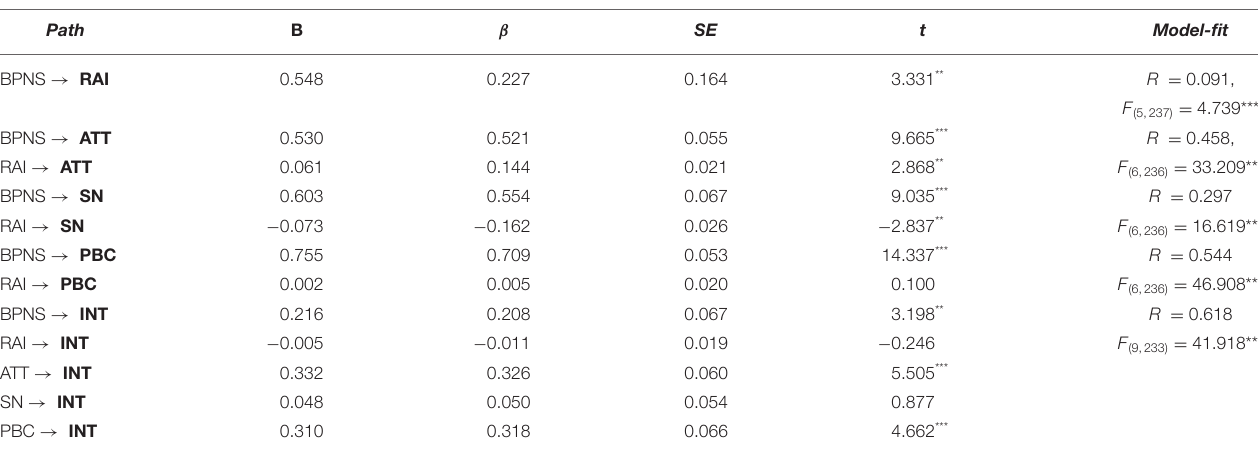
TABLE 3 | Path coefficients of direct effects for mediation model.